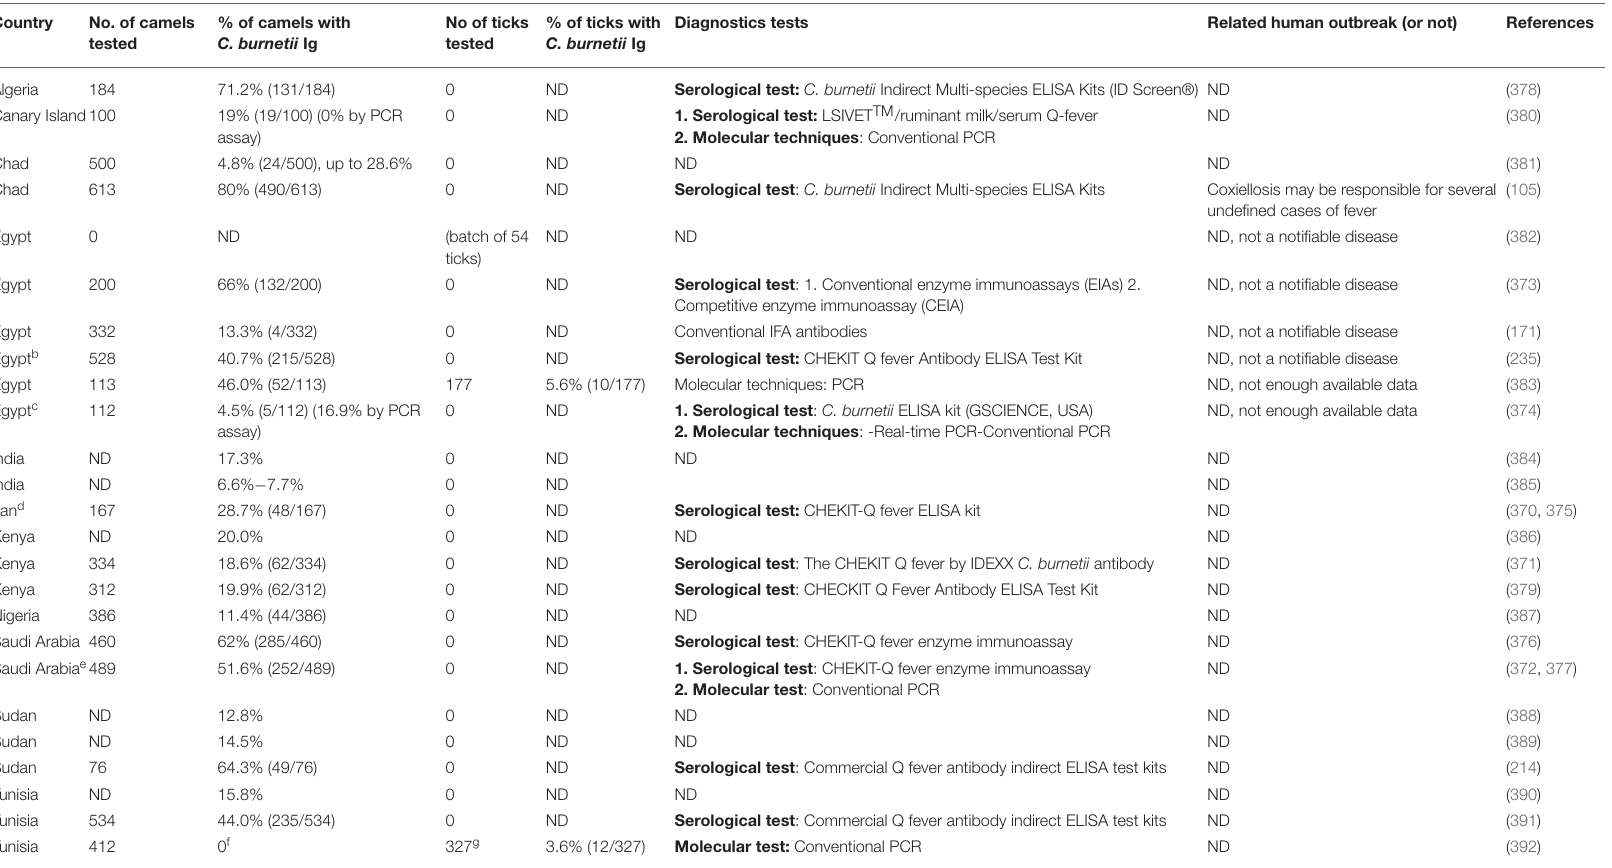
TABLE 4 | The seroprevalence of Coxiella burnetii in Camelus dromedarius camels and Hyalomma dromedarii ticks.